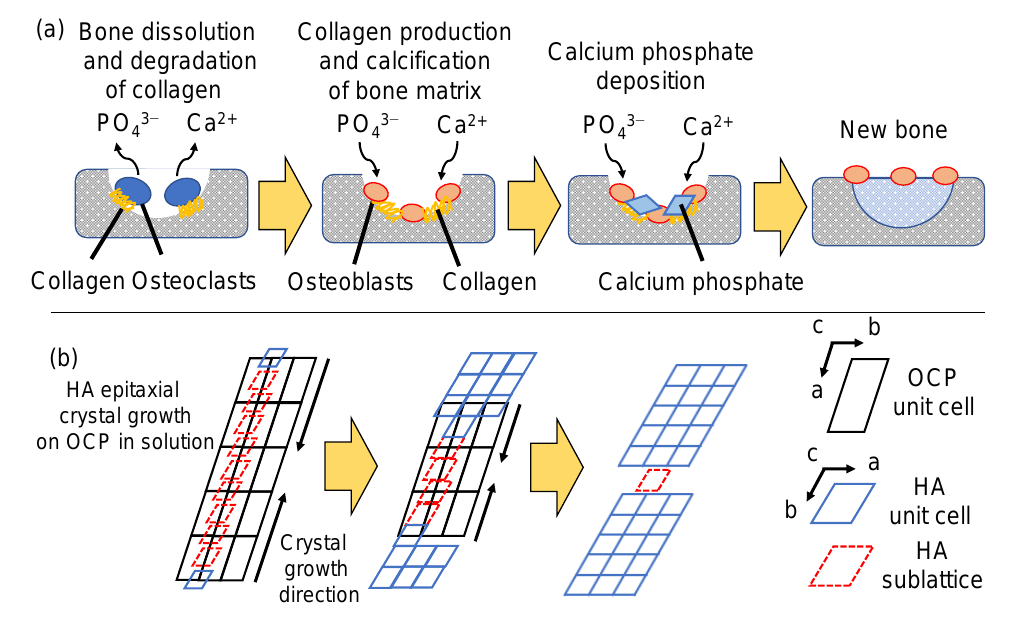
Figure 6. Illustration of ( a ) bone regeneration mechanism in vivo and ( b ) formation mechanism of HA on OCP in vitro.